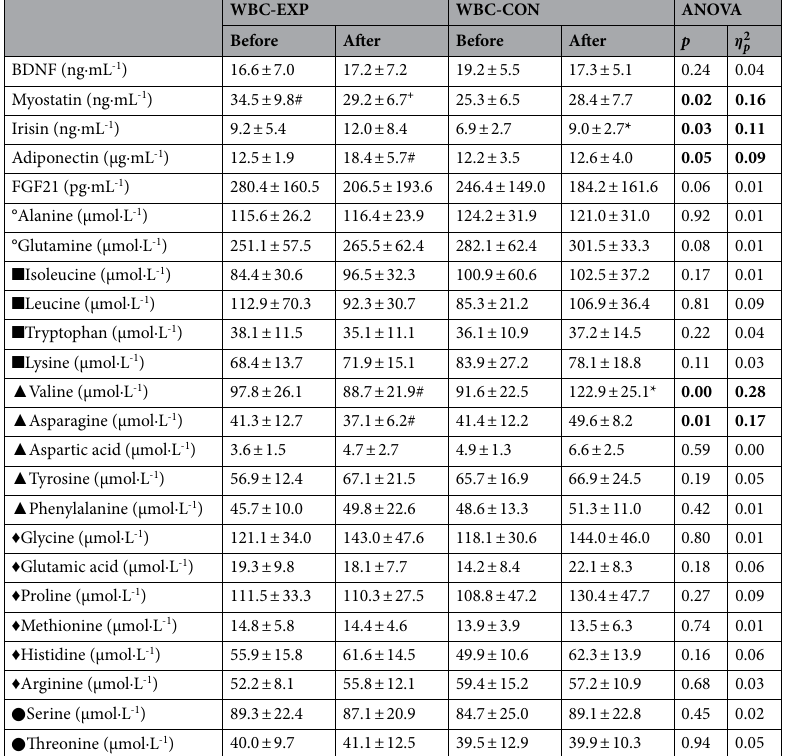
Table 4. The effect of chronic whole-body cryotherapy on biochemical indicators and amino acid profile among WBC-EXP (n = 22) and WBC-CON (n = 13). Data are presented as mean ± SD; *statistically significant difference between before and after measurements in the group; # statistically significant difference between groups at a time point, + statistically significant difference between before and after measurements MG from 2 WBC-EXP vs WBC-CON p < 0.05; η p - effect sizes (partial eta squared): ≥ 0.01 small, ≥ 0.06 medium and ≥ 0.14 large effect; Amino acids after deamination form keto acid like: °the most important gluconeogenic precursors in liver ; ■ acetyl-CoA; ▲ fumarate; ♦ alpha-ketoglutarate; pyruvate, which are further metabolized in gluconeogenesis process in the Krebs-cycle. Statistically significant group x time interaction are ●